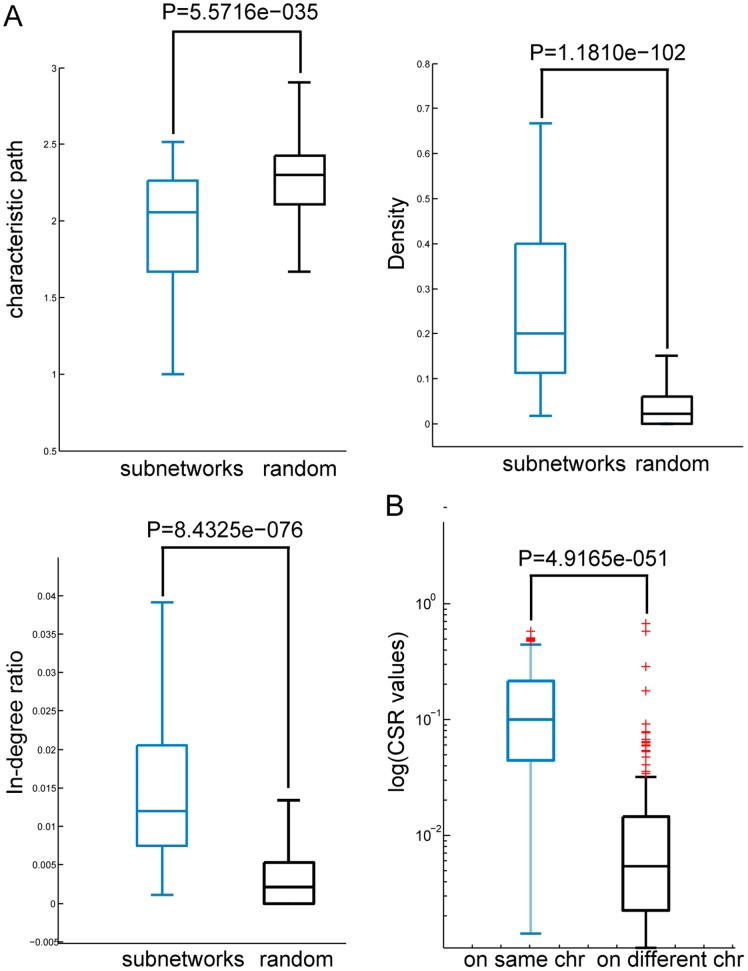
A summary of the sub-graph properties of the sub-networks associated with LD blocks.(A) The characteristic path length among genes in the same allele-specific sub-networks is significantly shorter compared to a randomization test. Moreover, the density and in-degree ratio of these sub-networks are significantly greater compared to a randomization test. Boxes of light color represent the distribution of the sub-graph properties (characteristic path length, density, in-degree ratio) of allele-specific sub-networks, and the black boxes correspond to random ones. (B) The panel shows the difference in CSR values between block pairs on the same chromosomes and on different chromosomes. P-values are calculated using the Wilcoxon rank-sum test.